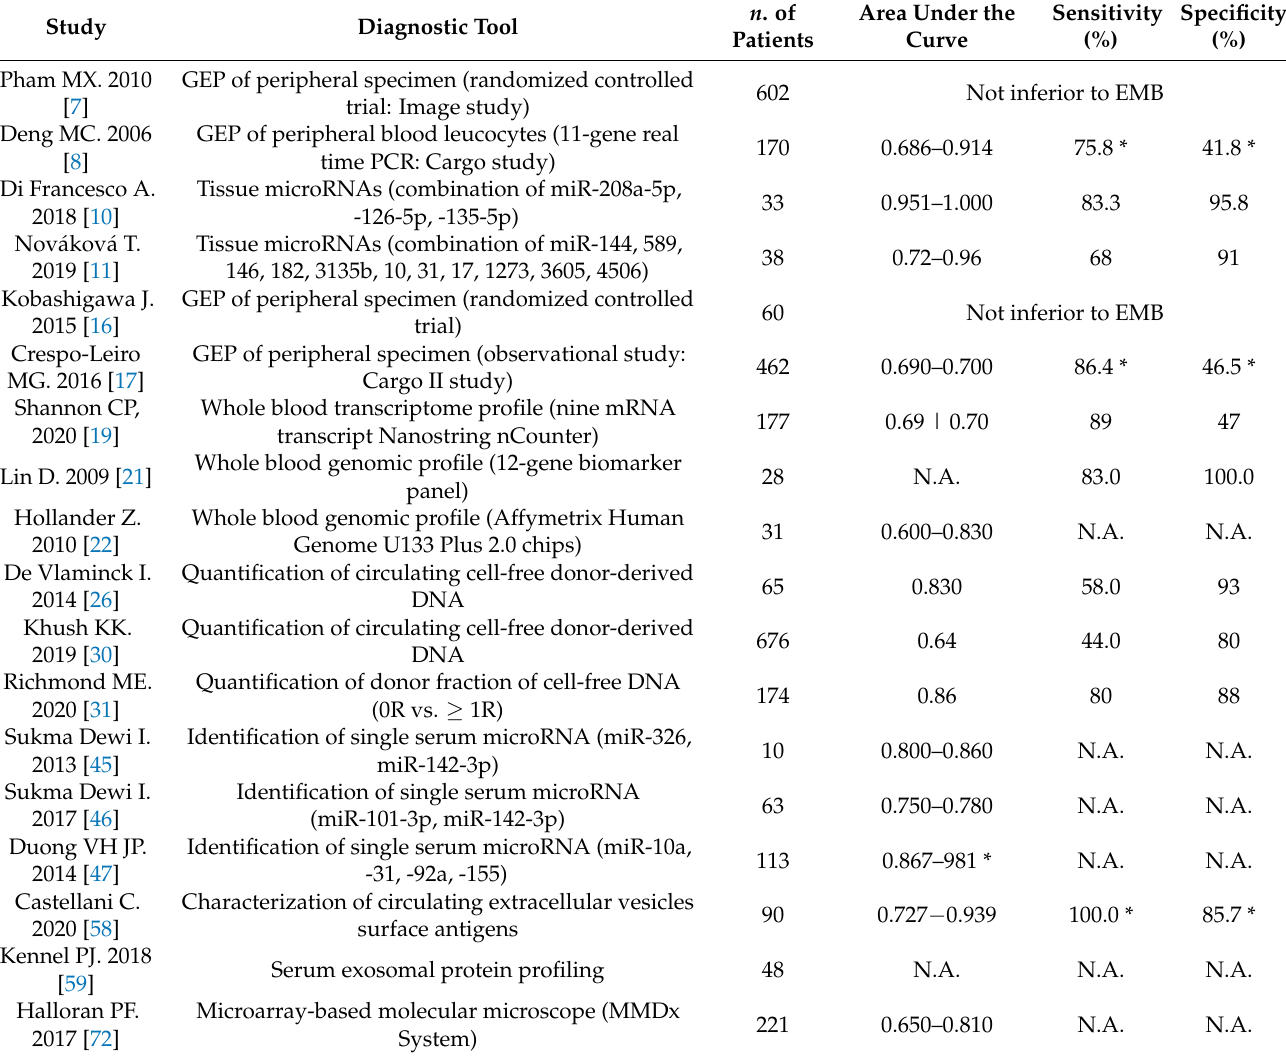
Table 1. Emerging biomarkers in the diagnosis of allograft rejection after heart transplantation. Study Diagnostic Tool